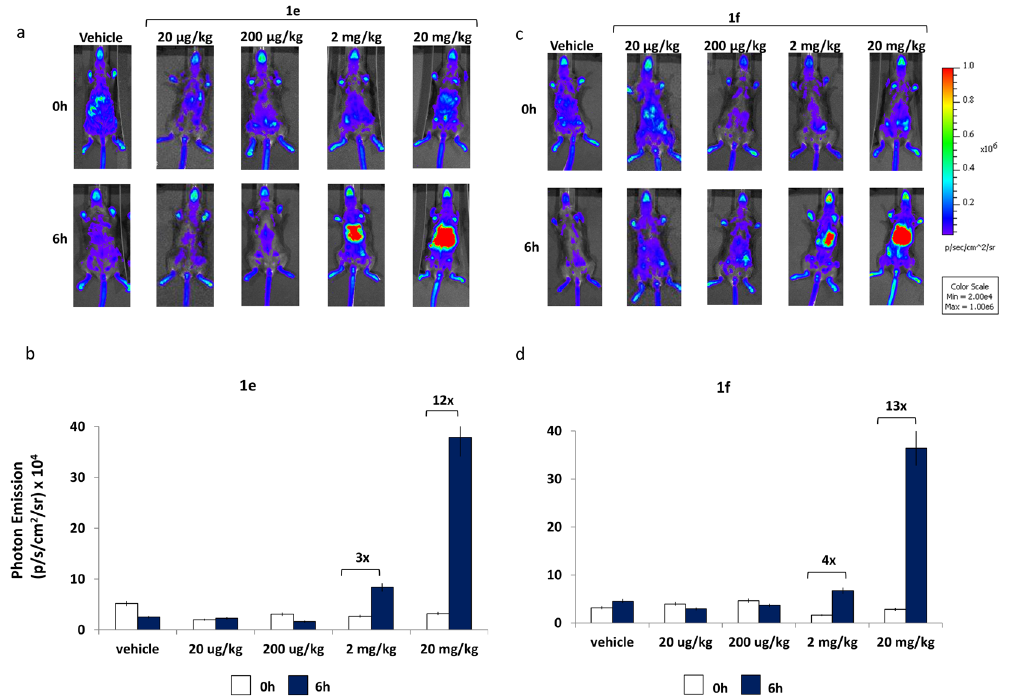
Figure 4. Effect of NCE on ER transcriptional activity in living ERE-Luc mice: dose- response. ( a ) Optical imaging of ERE-Luc mice at 0 and 6 hours after treatment with the indicated dosages of 1e compound. Photos portray whole body (ventral view) of a representative individual in a pseudocolor image indicating the intensity of photon emission from the different body areas. ( b ) In vivo BLI: quantification of photon emission whole body at 0 and 6 hours after injection of 1e at indicated dosages. ( c ) Optical imaging of ERE-Luc mice at 0 and 6 hours after treatment with the indicated dosages of 1f compound. Photos portray whole body (ventral view) in a pseudocolor image processed to indicating the intensity of photon emission from the different body areas of a representative animal for each group. ( d ) Whole body photon emission quantification at 0 and 6 hours after 1f treatment at indicated doses. Bars correspond to mean + / − SEM (n =